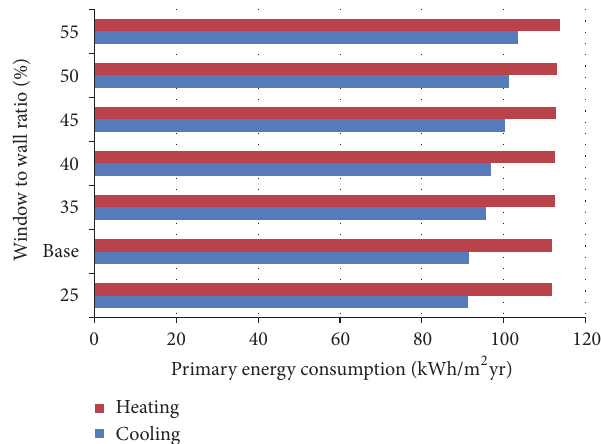
Figure 1: Primary energy consumption for cooling and heating according to the window-to-wall ratio of the target